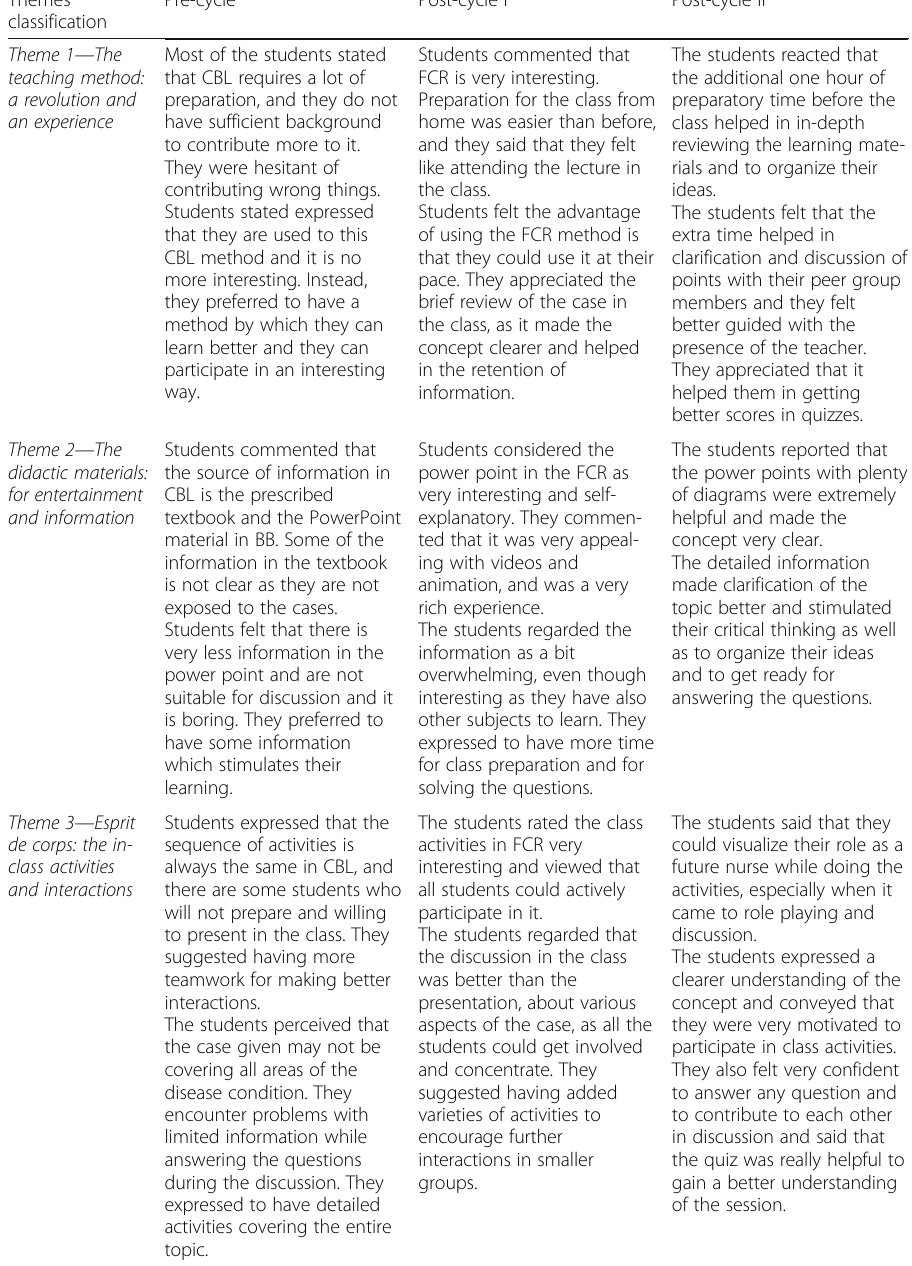
Table 2 Summary of findings from the focus group feedback with the major themes evolved Themes